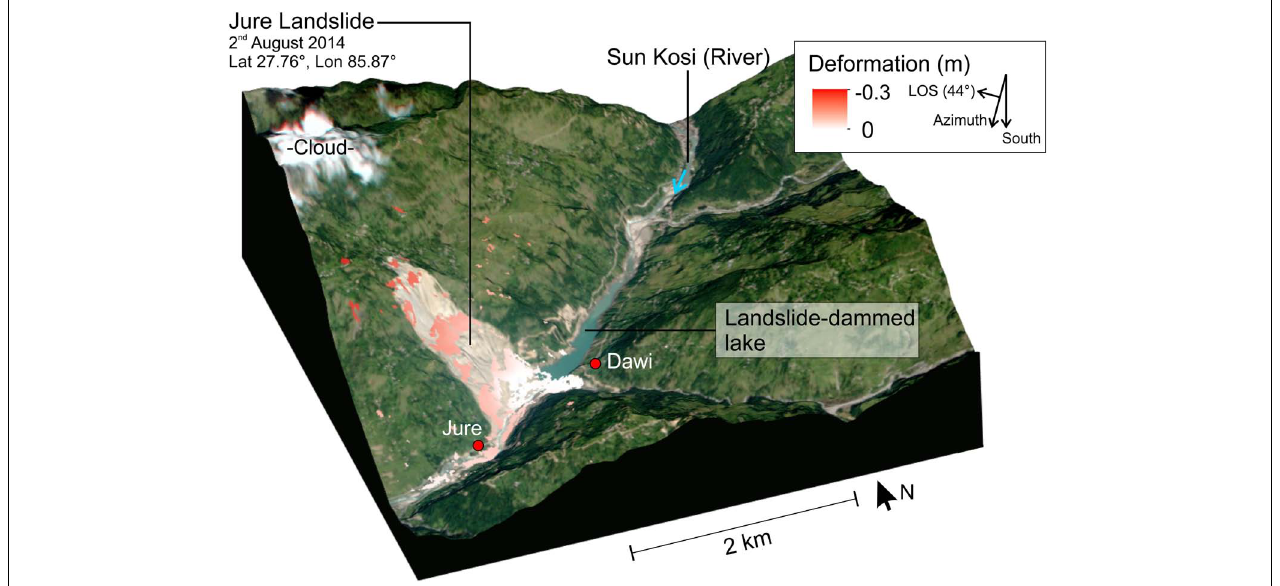
FIGURE 4 | Earthquake triggered landslide deformation measured from COSMO-SkyMed SAR imagery for the period between May 5–29, 2015. Background is a true color RapidEye image from October 11, 2014 (Planet Team, 2018). SAR Imagery is provided by the Italian Space Agency via the CEOS Working Group on Disasters Landslide Pilot.